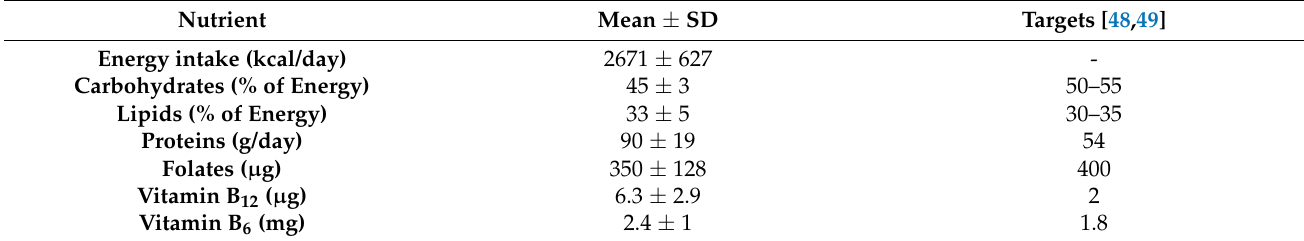
Table 2. Nutritional intake in the pericompetitive period, recommended dietary intakes, and nutritional goals for the Spanish